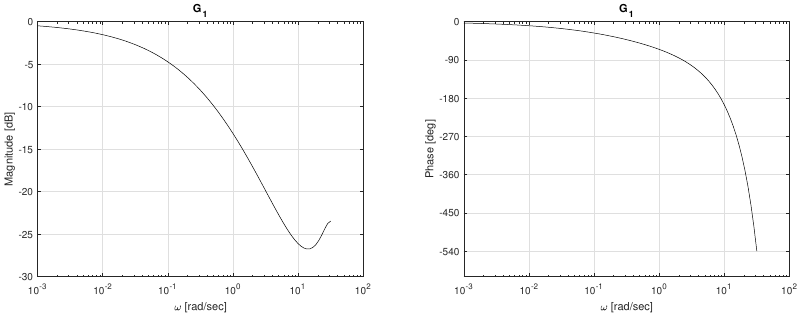
Figure 2. Frequency characteristics of the investigated systems—magnitude ( left ), phase ( right